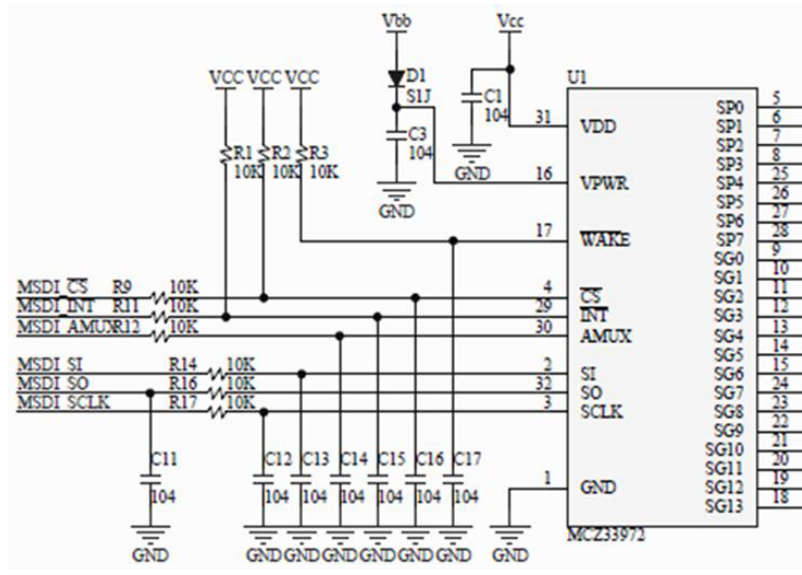
Figure 5. Schematic of the circuitry on the SJB power board.